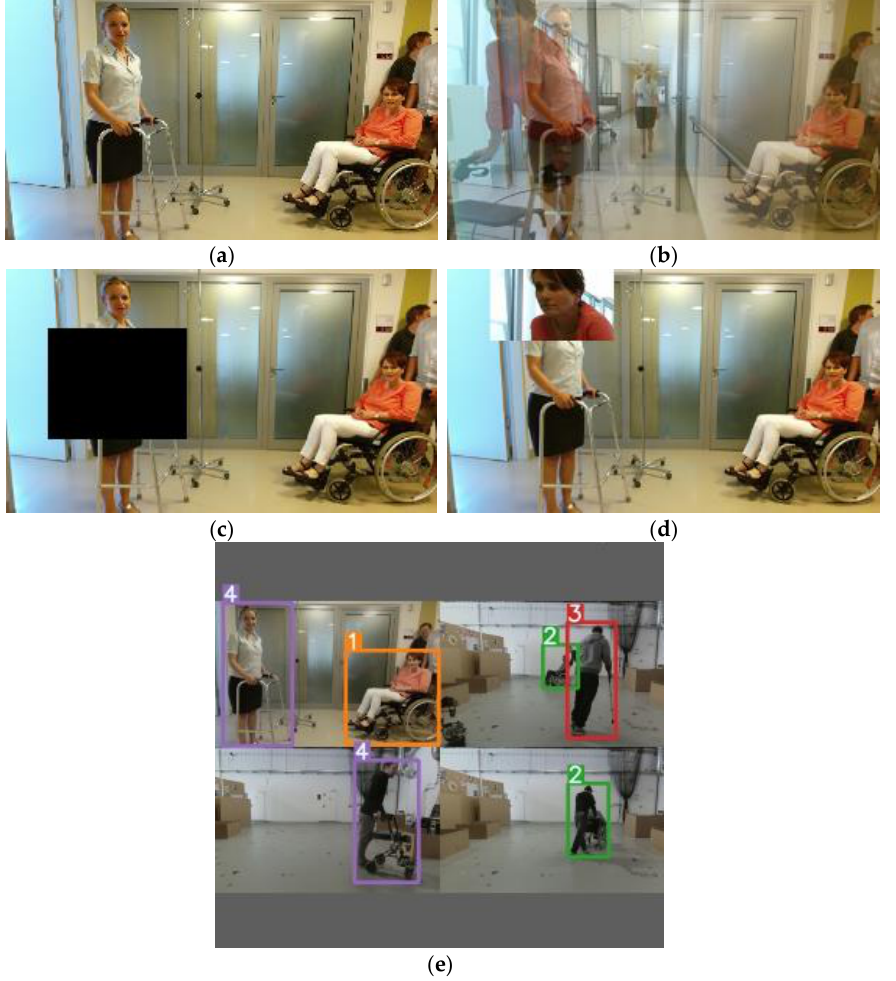
Figure 7. Examples of image augmentation. ( a ) Original. ( b ) MixUp 50%. ( c ) CutOut. ( d ) CutMix. ( e ) Mosaic.